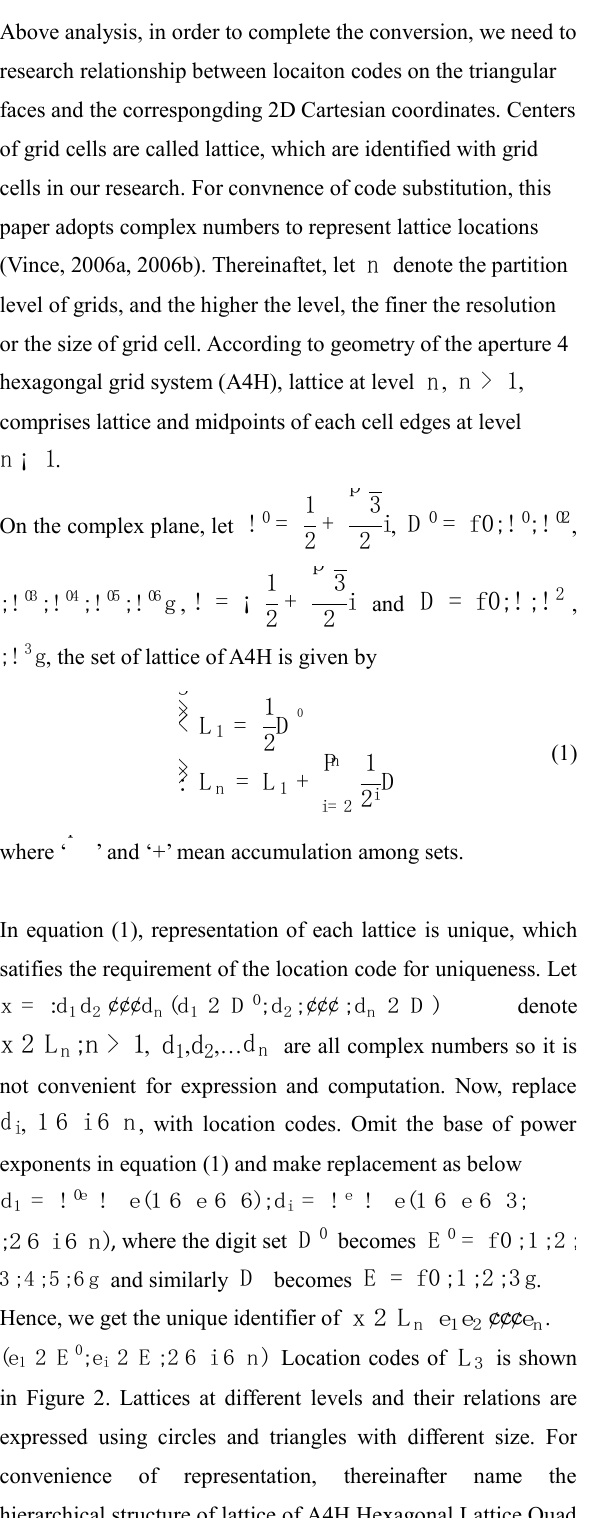
in Figure 2. Lattices at different levels and their relations are expressed using circles and triangles with different size. For convenience of representation, thereinafter name the hierarchical structure of lattice of A4H Hexagonal Lattice Quad Tree (HLQT).